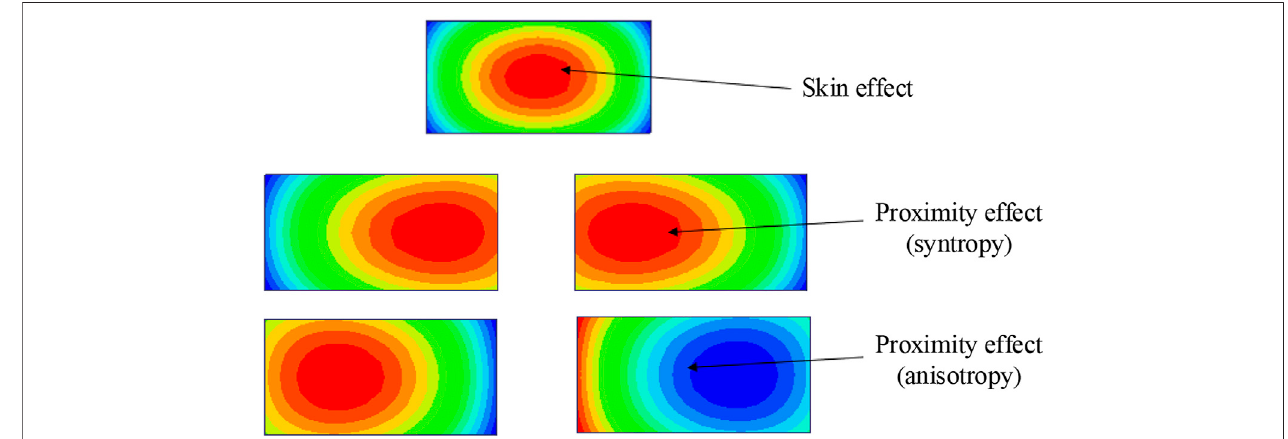
FIGURE 11 | Skin effect and proximity effect.